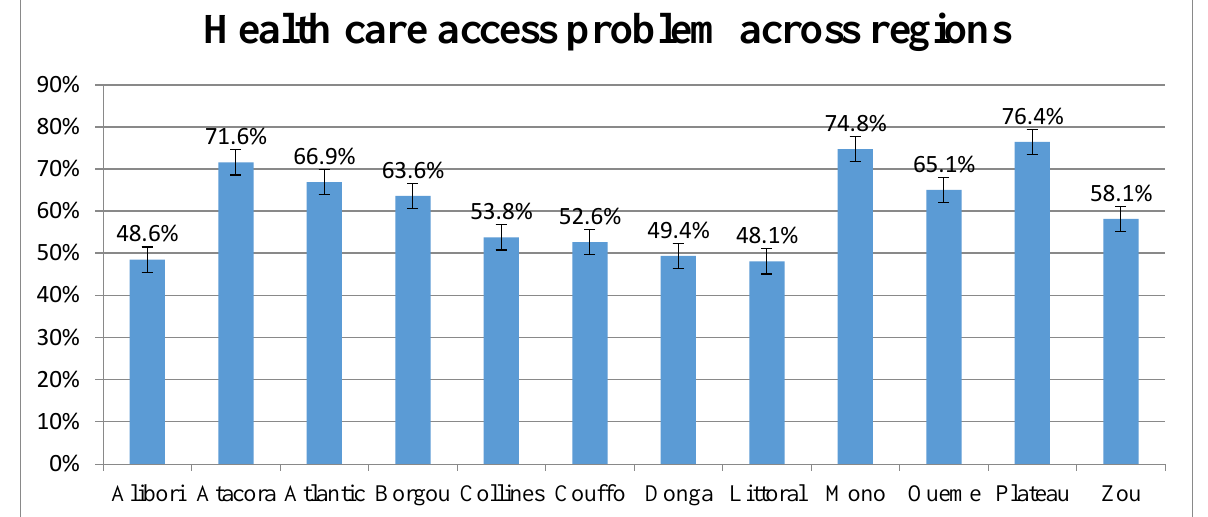
Figure 3. Magnitude of healthcare access problems among women of reproductive age (15–49) in Benin across regions: Evidence from 2018/2019 Benin DHS.